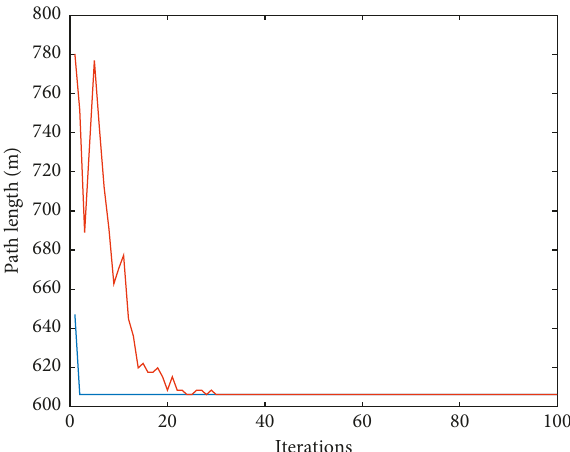
Figure 12: Average distance and shortest distance after optimization. Table 2: Comparison of path simulation results at r � 15m. Number of cluster heads ( r � 15m)